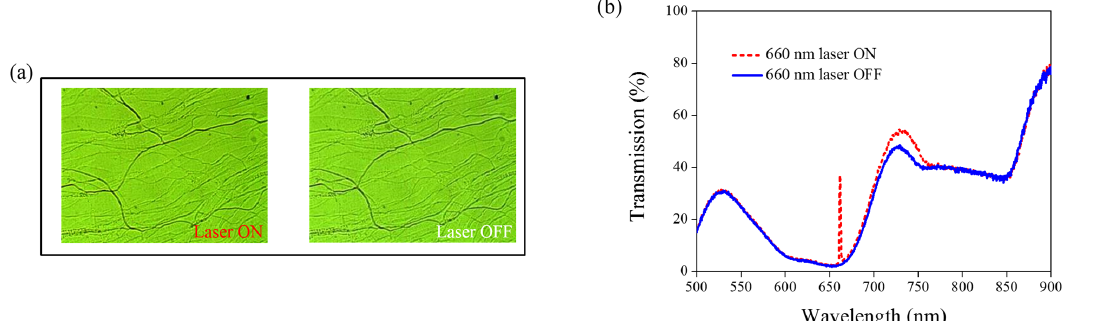
Figure 10. ( a ) POM images (picture area: 270 μ m × 320 μ m) and ( b ) transmission spectra of AQ dye-doped CLC containing A1 molecules (3 wt% AQ dye, 15 wt% A1, 20 wt% S811, and 62 wt% MDA3461) under different conditions of 660-nm wavelength laser exposure. The laser intensity was 100 mW/cm 2 .